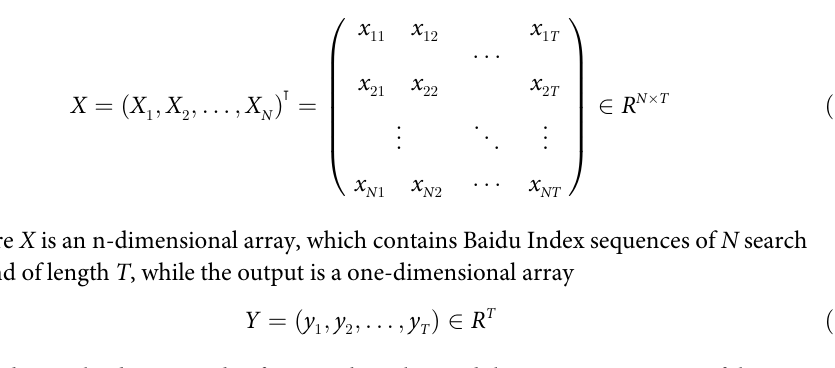
Note: Our primarily selected search terms in Table 1 are labeled in this format “Chinese name (English name, variable